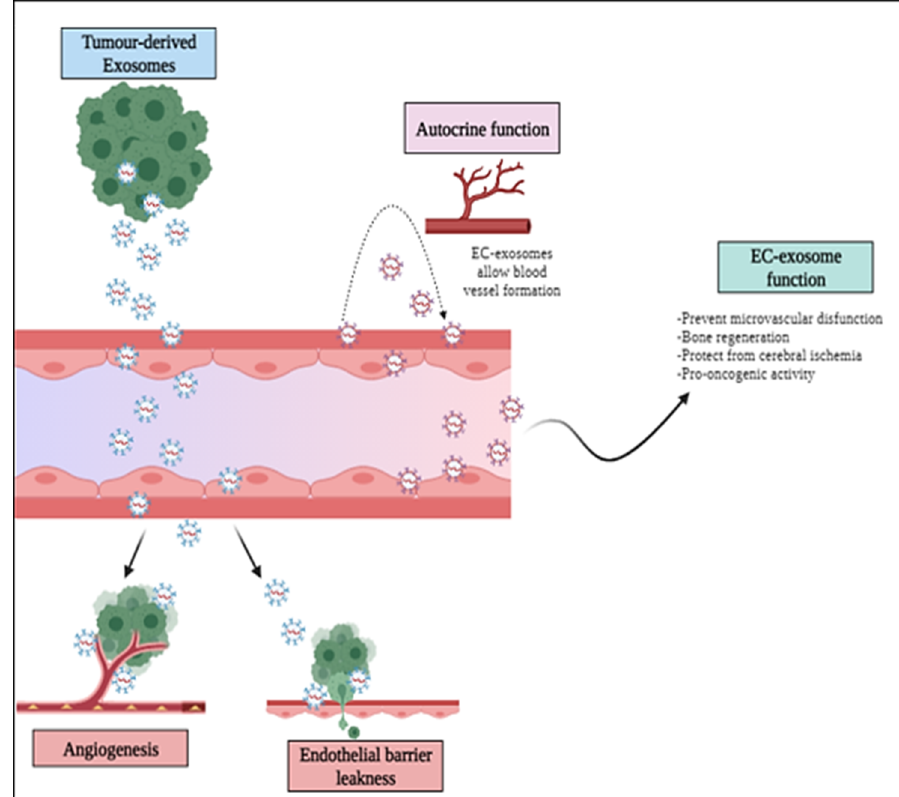
Figure 2. Exosome-mediated regulation of the vasculature in cancer and in other pathologies. Tumor-derived exosomes may induce EC proliferation and migration, promoting the angiogenic process and have been shown to elicit leakiness of endothelial barriers and vascular permeability, thus, fostering cancer cell ingress into the bloodstream for metastatic dissemination. Furthermore, exosomes are released by ECs to self-regulate the same or neighboring cell population, including in the tumor microenvironment.